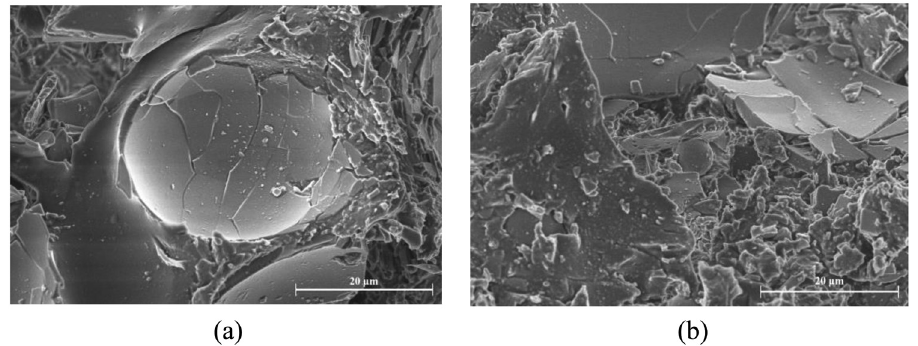
Figure 8: SEM of syntactic foam panels after impact: ( a ) F70MC0.6M - II and ( b ) F70C0.6